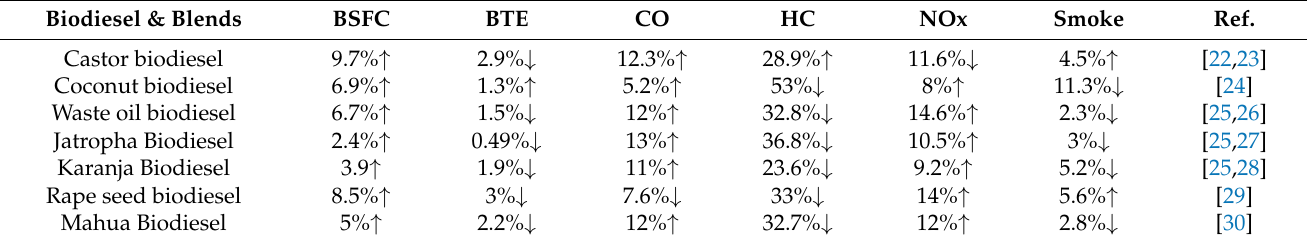
Table 2. Comparison of engine performance and emissions of castor biodiesel with other biodiesels. Biodiesel &